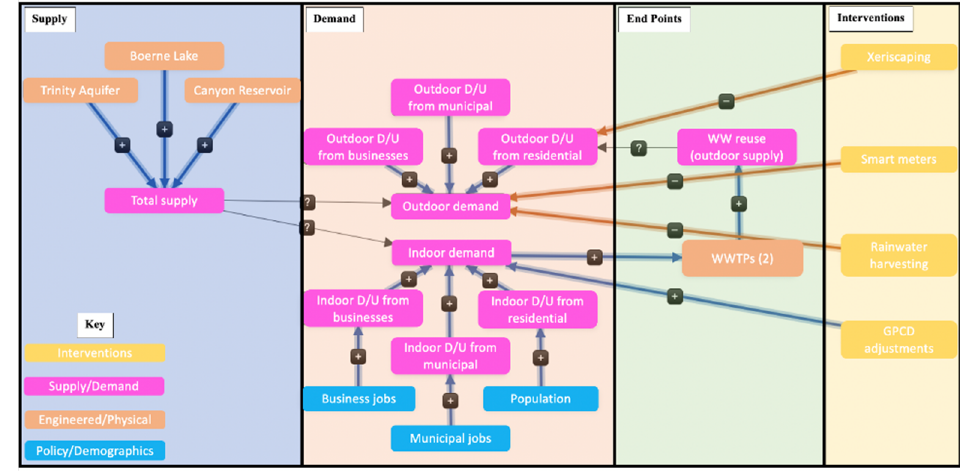
Figure 2. Water System Causal Loop Diagram for Boerne, Texas. Note: Demand/Use (D/U); Wastewater Treatment Plants (WWTPs). The mentioned conservation practices include smart meters, xeriscaping, and rainwater harvesting.